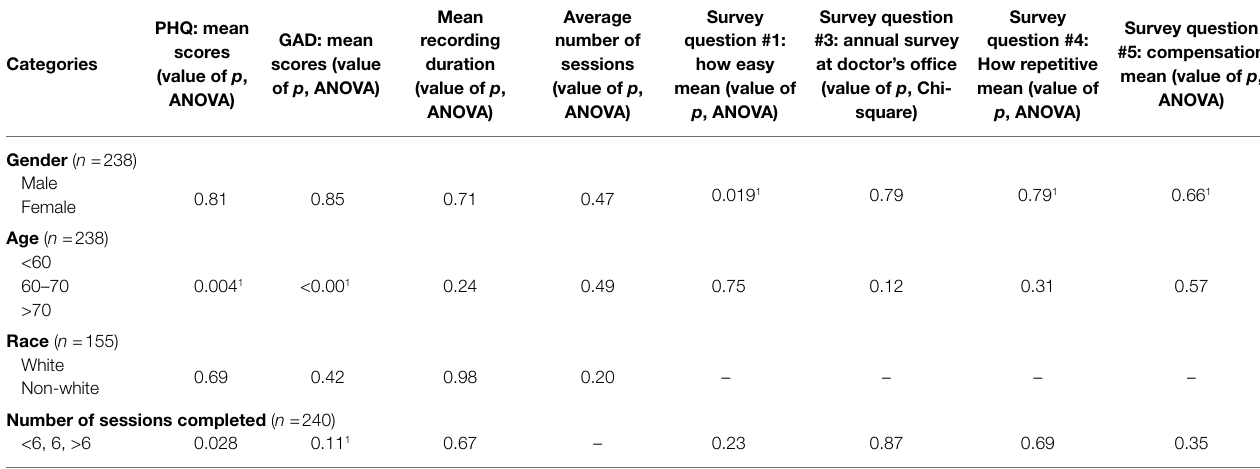
TABLE 3 | Demographics and session duration/frequency – ANOVA, Welch’s ANOVA and Chi-squared tests with initial PHQ/GAD scores and survey answers in Group Positive participants.